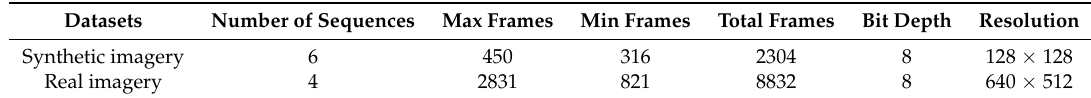
Table 2. Details of the dataset.